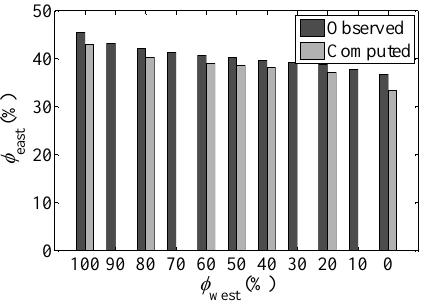
Figure 12. Observed and computed portions of outflow discharge through the east face ( ϕ east ) when the inflow through the north face ( ϕ north ) is varied from 0 up to 100%.